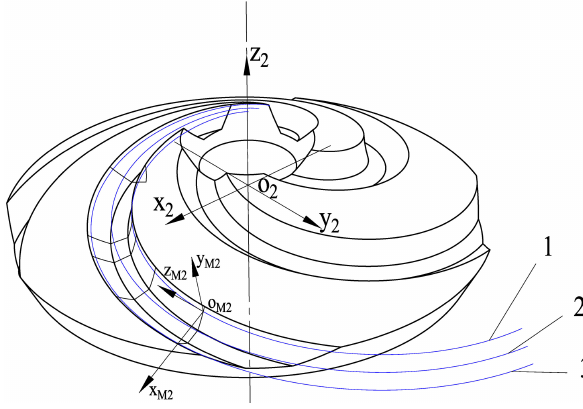
Figure 4. Schematic diagram of the driven line gear.